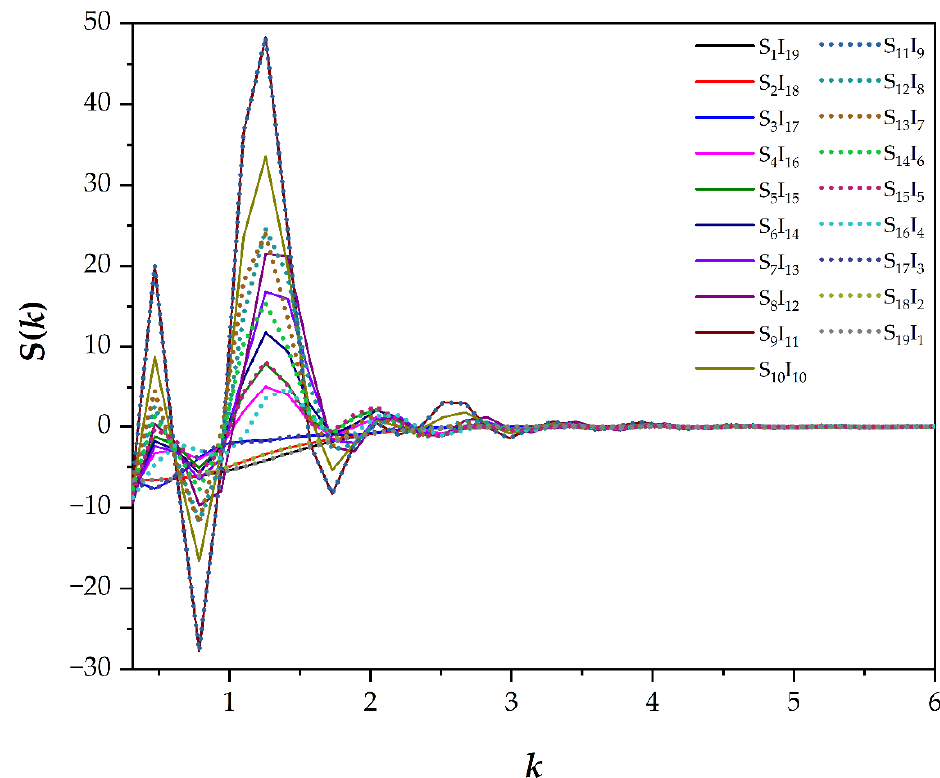
Figure 3. Structure factors S( k ) in different coarse-grained models versus a frequency k . Some lines are illustrated in a dotted style to ensure that all data can be seen.